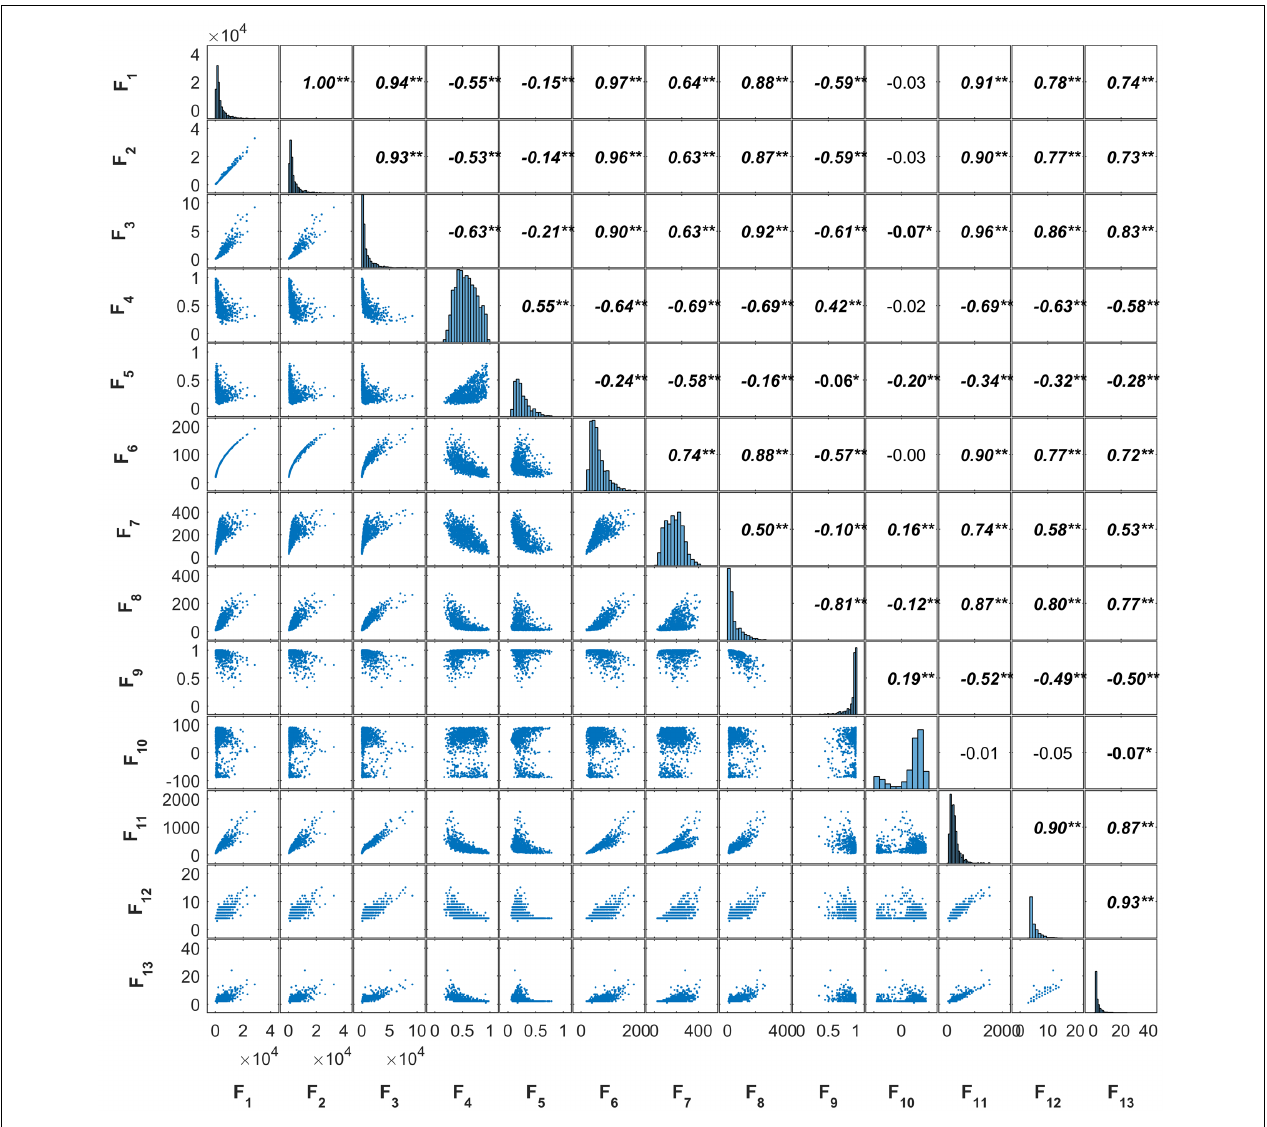
FIGURE 5 | The correlation among the 13 objects’ features for the Toulouse site ( ∗∗ : 0.01, ∗ : 0.05). The abbreviation of features refers to names in Table 2